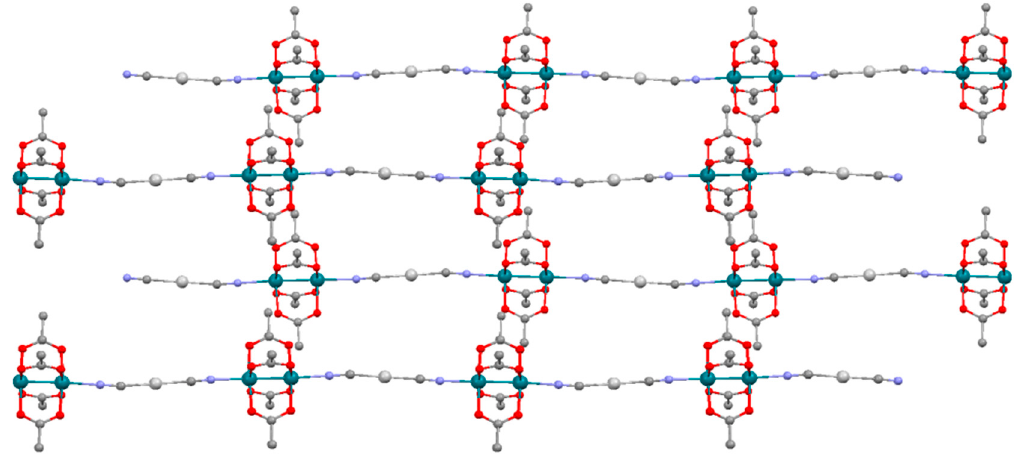
Figure 3. View of the chains that form 3a along the a axis in a 2 × 2 × 2 cell packing. Rhodium: green; oxygen: red; carbon: dark grey; nitrogen: purple; silver: pale grey. Hydrogen atoms are omitted for clarity.